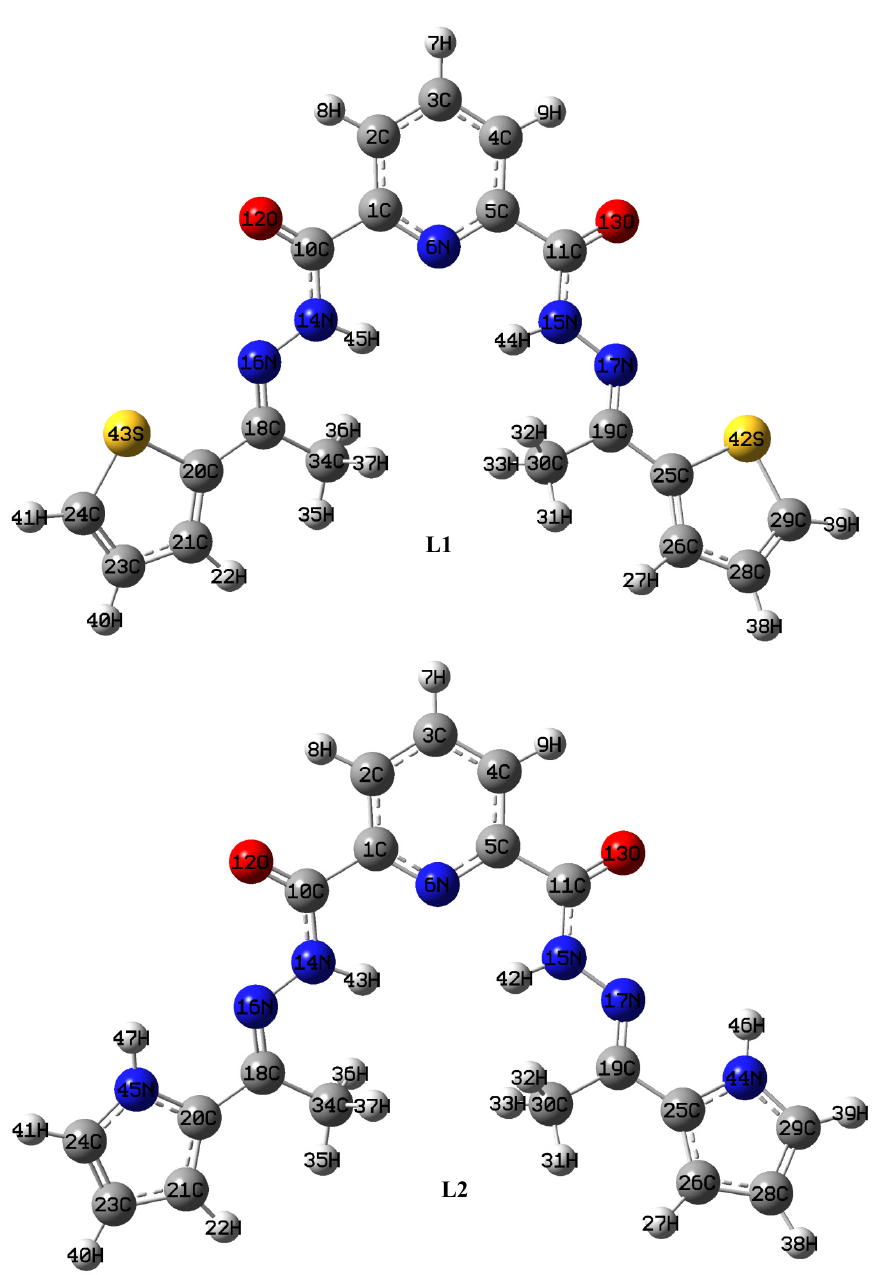
Figure 1. Optimized structures of L1 and L2 generated at the B3LYP/6-311+ G (d, p) level of theory.